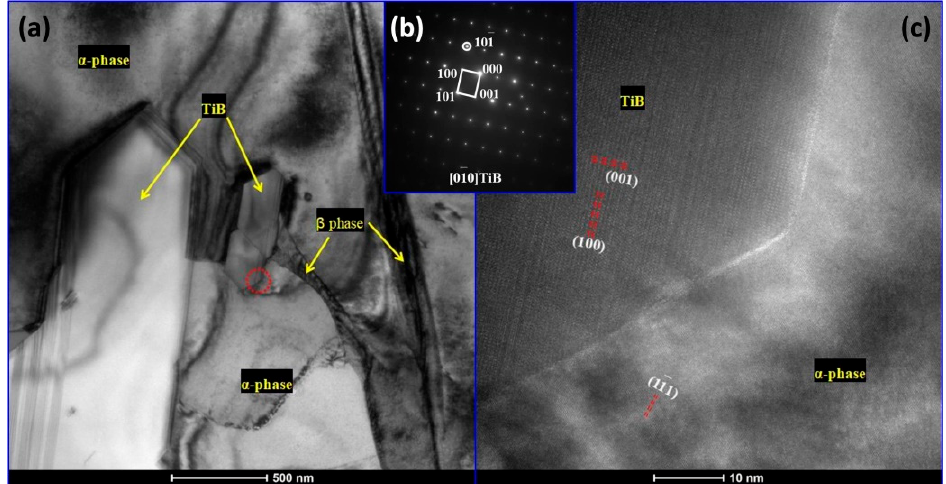
Figure 13. TEM micrographs: ( a ) BF image of the TiBw/matrix region; ( b ) selected area electron diffraction of TiBw; ( c ) high resolution transmission electron microscope of the TiBw/ α -phase interface.